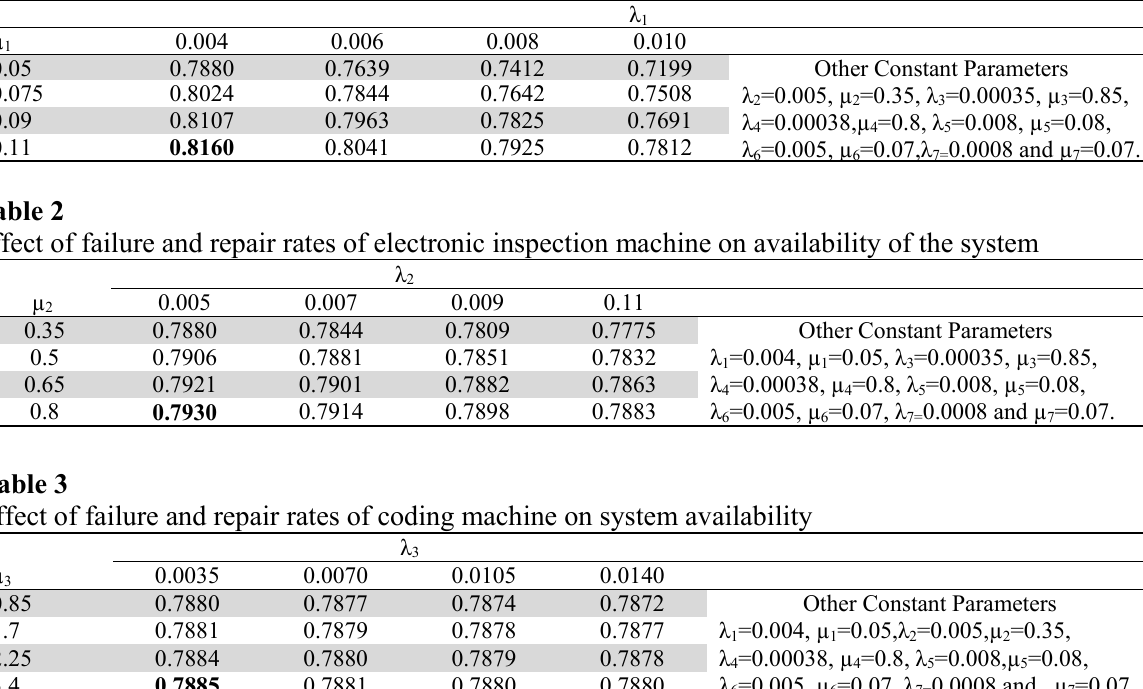
Effect of failure and repair rates of Uncaser machine on availability of the system